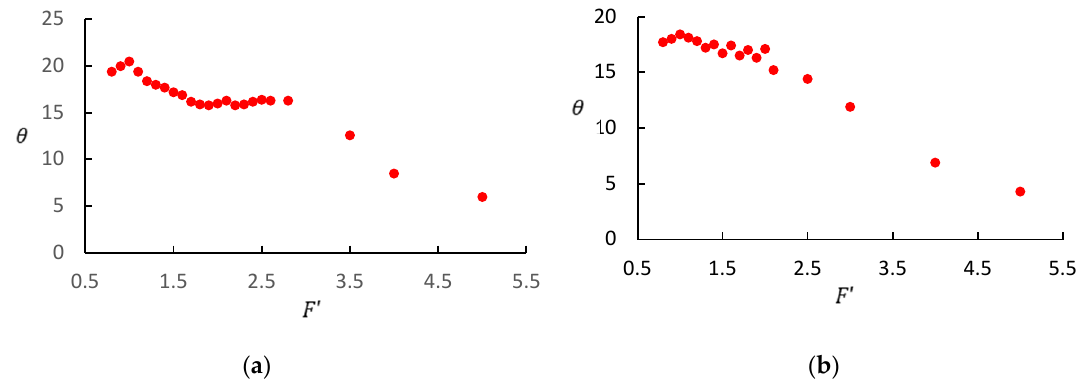
Figure 12. Measured apparent wake angles 𝜃 in degrees plotted against the Froude number for the flow past a Kelvin source with 𝜖′ = 1 ( a ) and a Rankine source with μ ’ = 0.5 ( b ).